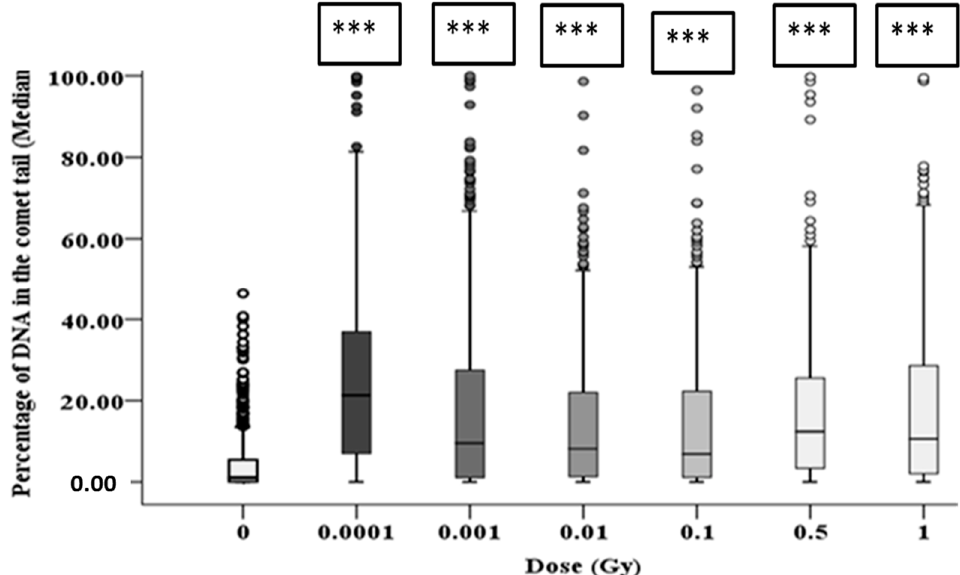
Figure 7. Percentage of DNA (damage) in the comet tail in HF19 cells 1 h following alpha-particle irradiation. HF19 cells were exposed to different doses of alpha irradiation and incubated for 1 h prior to performing the comet assay. The DNA damage was measured by the comet assay (% tail DNA) as combined data for 1000 cells which were scored from two separate, independent experiments. The box-plot shows the distribution of damage (*** = p ≤ 0.001).